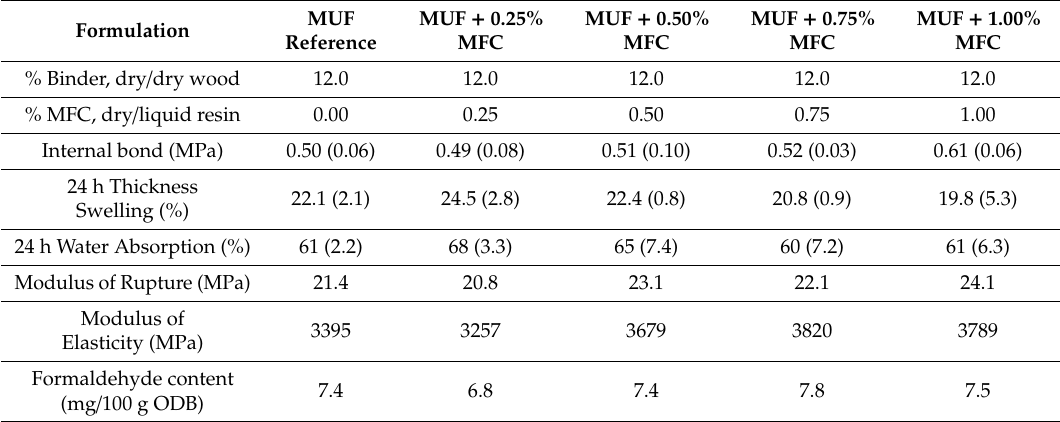
Table 8. Waferboard panels analysis, MFC 10% increasing levels, resin stable, Approach